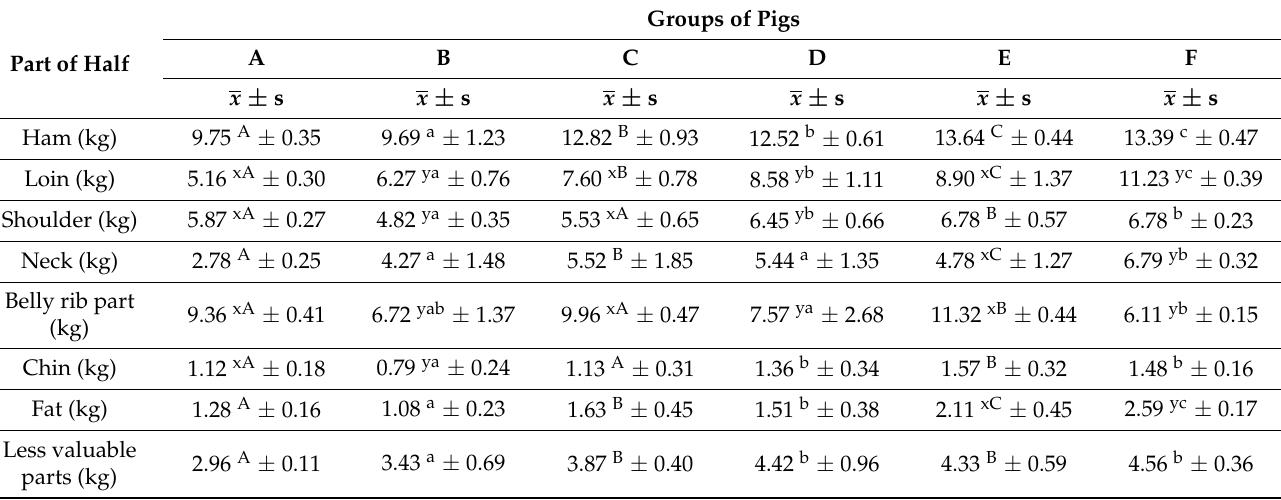
Table 3. Shares of the basic parts of the pig carcasses